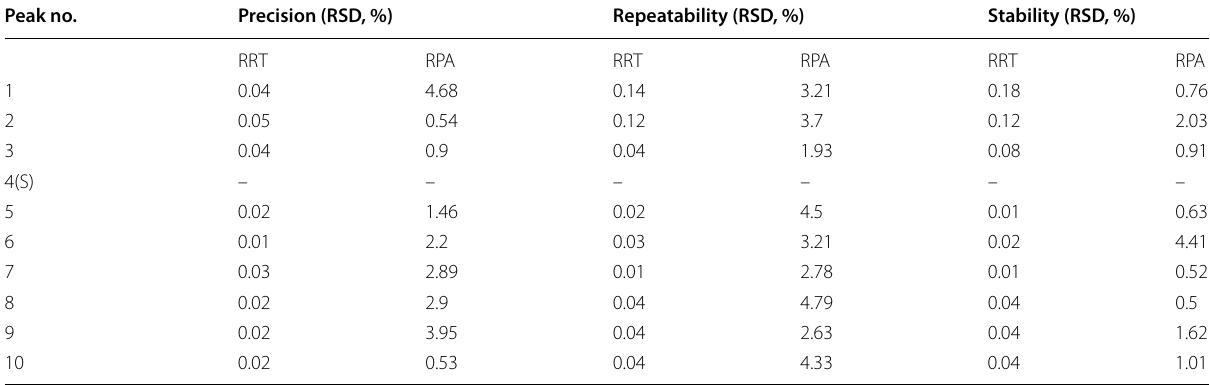
RRT relative retention time, RPA relative peak area